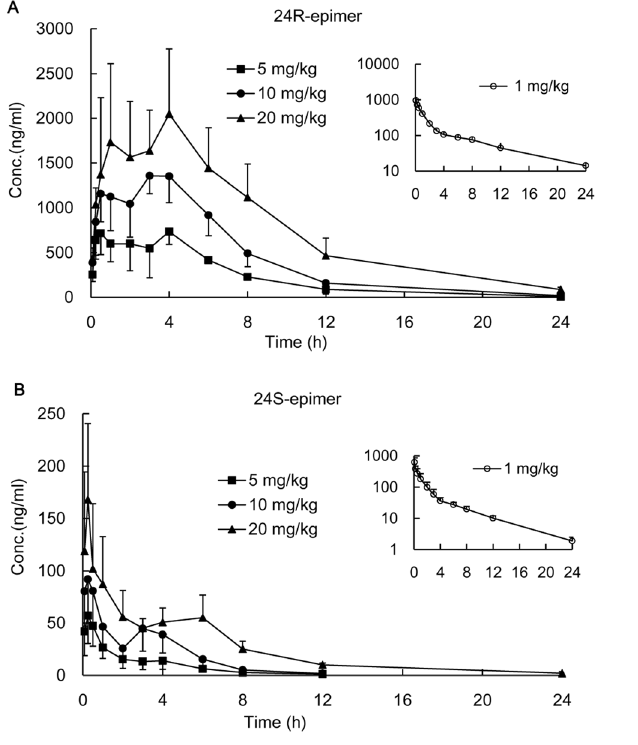
Figure 2. Plasma concentration-time profiles of 24R-epimer and 24S-epimer in rats. The intragastric administration groups were administered 24R-epimer (A) or 24S-epimer (B) at doses of 5, 10 and 20 mg/kg, respectively. The intravenous groups were presented in smaller figure administered 1 mg/kg of 24R-epimer or 24S-epimer, respectively. n=5 per